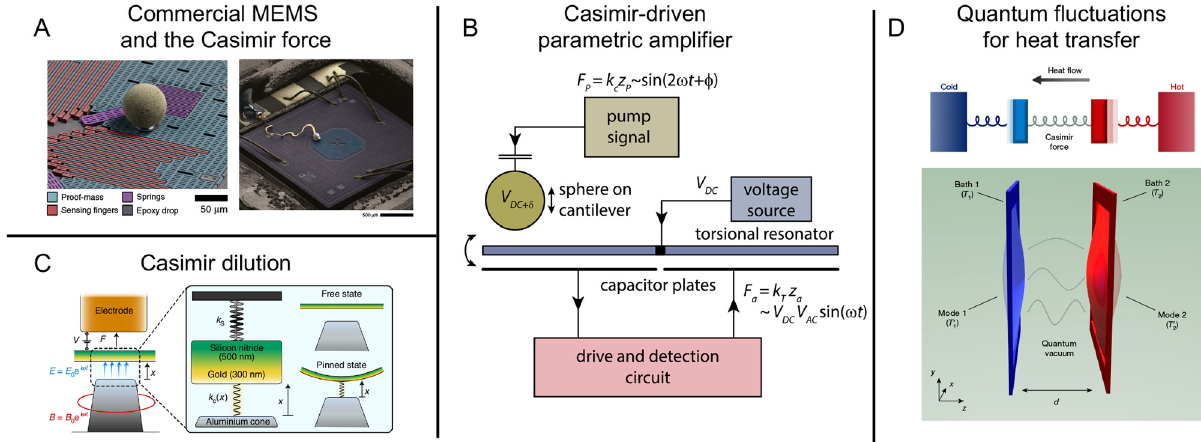
Figure6: ApplicationoftheCasimirforcetonanotechnology.(A)UseofacommercialMEMSsensortomeasuretheCasimirforce.Reproduced with permissionfrom the study by Stange et al. [150].Copyright 2019, Nature Publishing Group. (B) Casimir parametric ampli fi er. Reproduced with permissionfrom the study by Imbodenet al. [151]. Copyright2014, AIP Publishing. (C) Casimirforce incorporated intoan optomechanical cavity giving rise to dissipation dilution. Reproduced with permission from the study by Pate et al. [152]. Copyright 2020, Nature Publishing Group. (D) Heat transfer driven by quantum fl uctuations. Reproduced with permission from the study by Fong et al. [153]. Copyright 2019, Nature Publishing